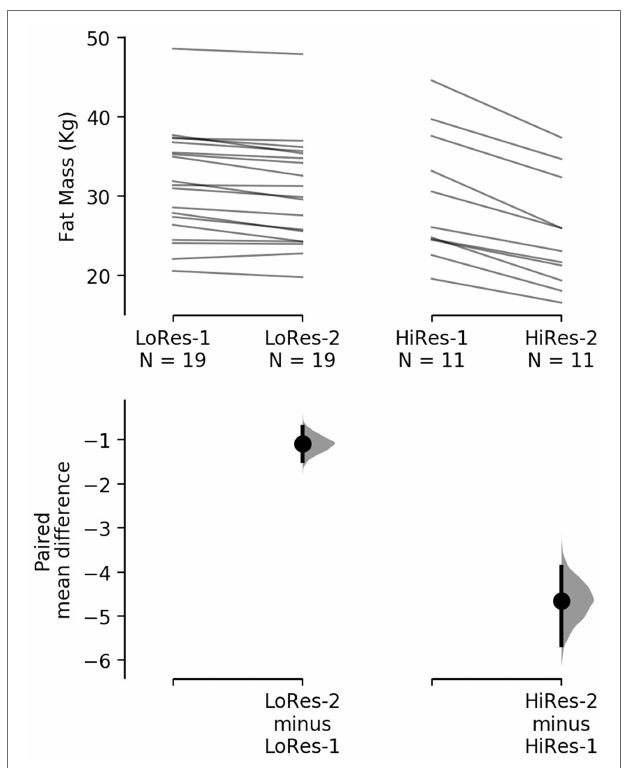
FIGURE 3 | Cumming plot with individual responses to decrease absolute fat mass after the 12-week intervention by low (left) and high (right) responders. The raw data (kg) are plotted on the upper axes; each paired set of observations is connected by a line. On the lower axes, each paired mean difference is plotted as a bootstrap sampling distribution. Mean differences are depicted as dots; 95% confidence intervals are indicated by the ends of the vertical error bars. LoRes-1, initial assessment of low responders; LoRes-2, final assessment of low responders; HiRes-1, initial assessment of high responders; and HiRes-2, final assessment of high